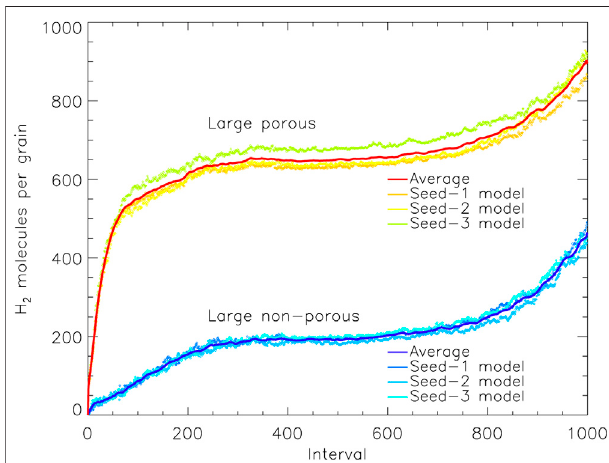
FIGURE 4 | The amount of molecular hydrogen present on the grain vs. relative time intervals, for the large porous and non-porous grain models. The solid lines show a moving average (of period 10) over the three runs for either grain type, with the data from the individual runs plotted as individual points. Interval 1,000 corresponds to the end time of the models shown, which are shown individually for each model in Table 4